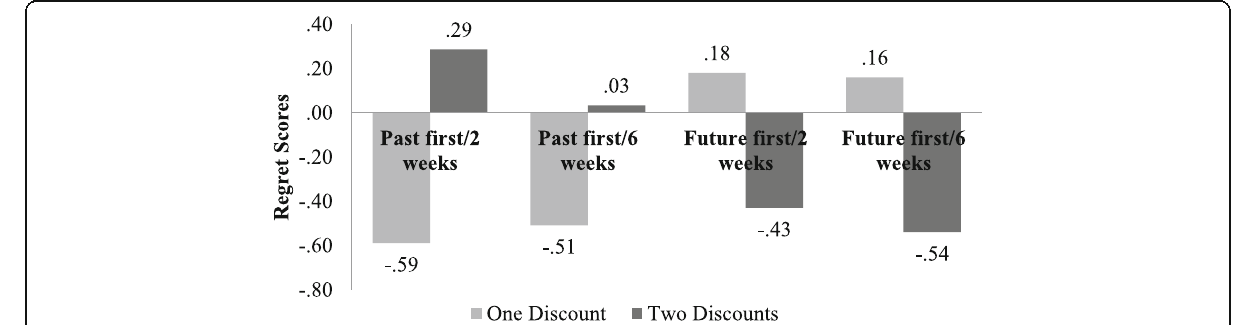
Fig. 1 Mean regret scores for the scenarios with one discount and two discounts in all four